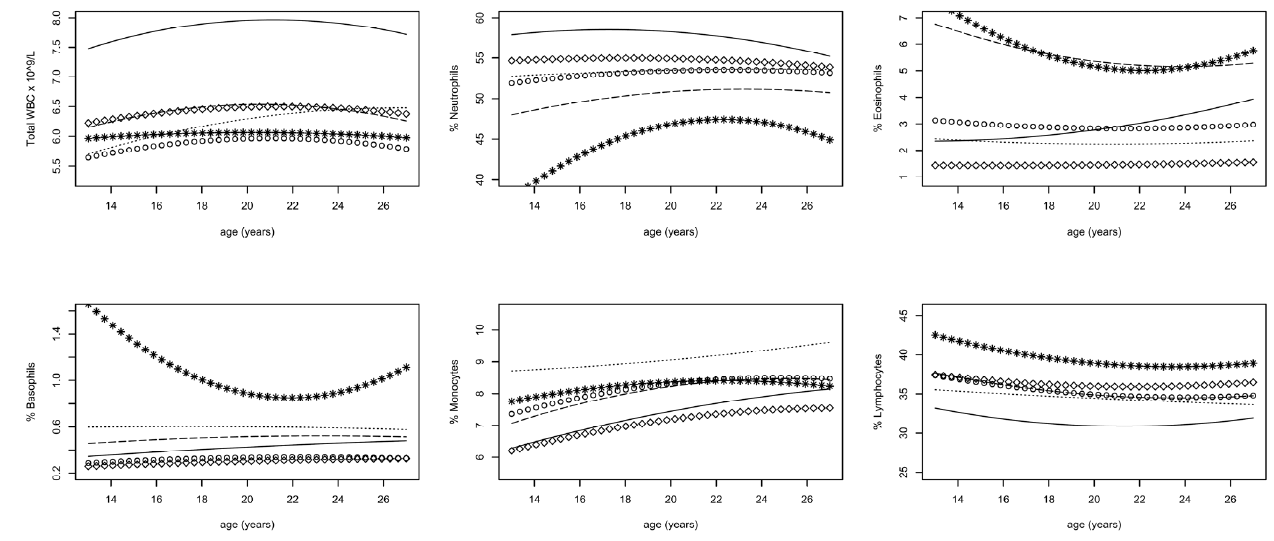
Figure 1. Clusters according to total and differential white blood cells (WBC)